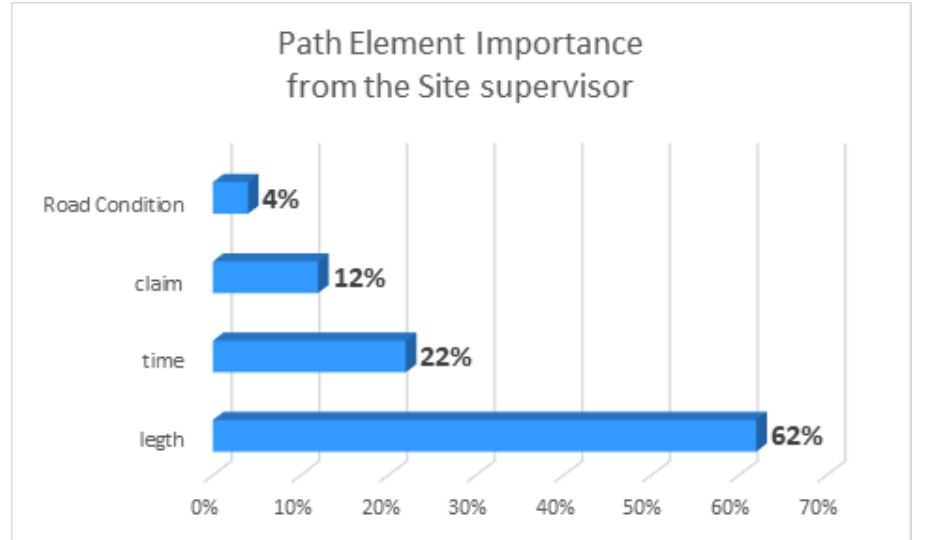
Figure 2. Path element importance from the site supervisor.